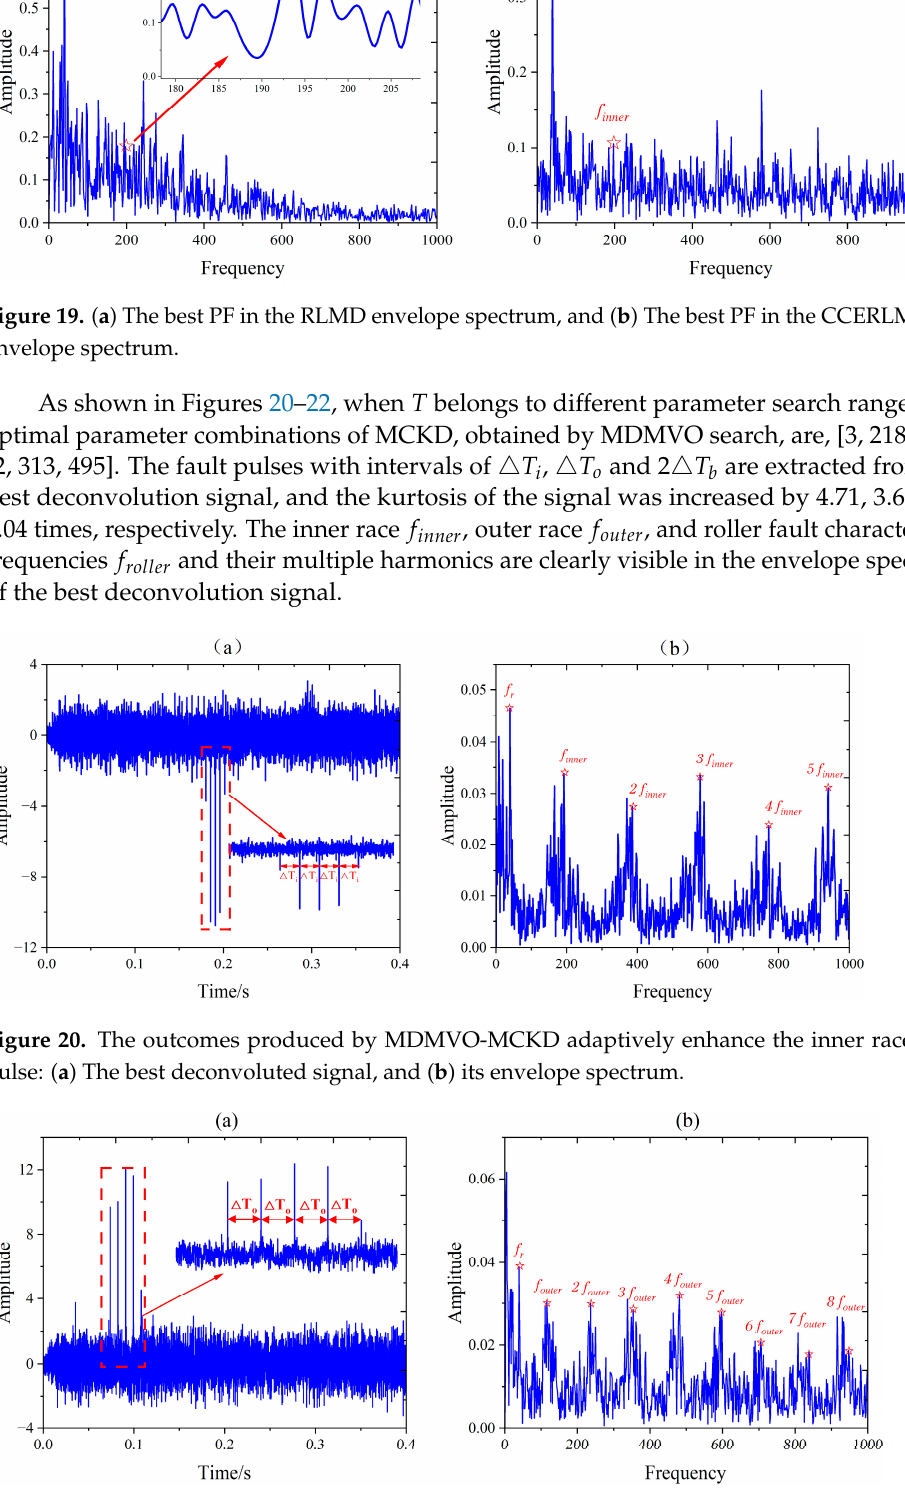
Figure 18. The SI value for each PF were calculated by processing the compound fault signal at 2400 r/min: ( a ) RLMD and ( b ) CCERLMDAN.